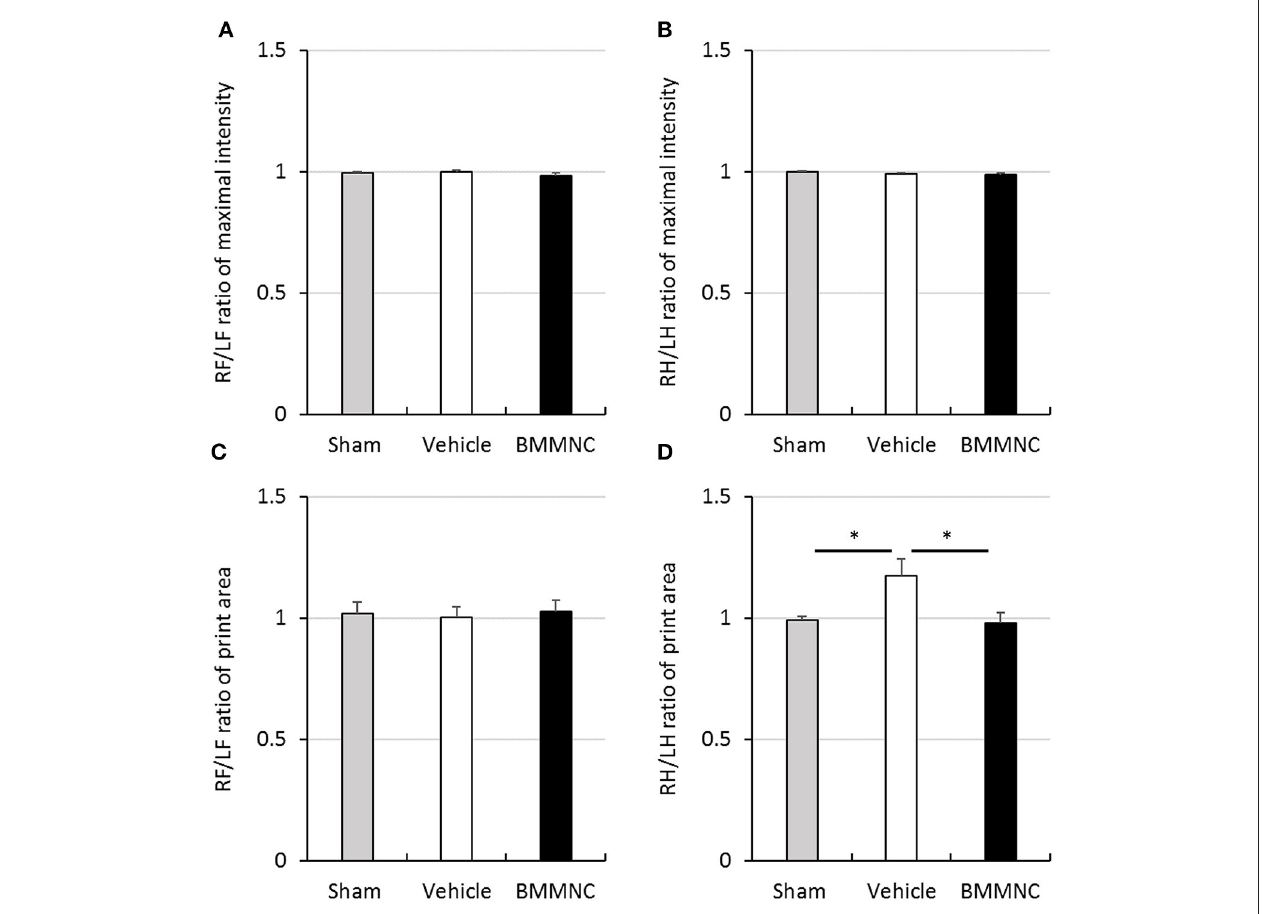
FIGURE 7 | Gait analysis. Gait analysis was performed to assess right/left ratio of the maximal intensity of forepaw (A) and hind paw (B) and right/left ratio of print area with forepaw (C) and hind paw (D) on P31. (A,B) There was no significant difference in the maximal intensity of forepaw and hind paw. (C) A significant difference was not observed in the right/left ratio of print area with forepaw. (D) Right/left ratio of print area with hind paw in the vehicle group was significantly larger than that in the sham group (* p < 0.05, Dunnett’s test). Moreover, it was significantly smaller in BMMNC group than in the vehicle group (* p < 0.05, Dunnett’s test). Data represent the mean ± standard error of the mean (sham, n = 9; vehicle, n = 8; BMMNC, n = 8). RF, right forepaw; LF, left forepaw; RH, right hind paw; LH, left hind paw.